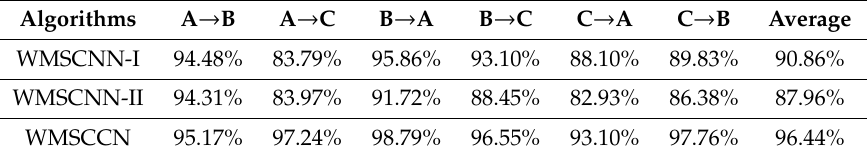
Table 3. Experimental results of the generalization of the capsule network.